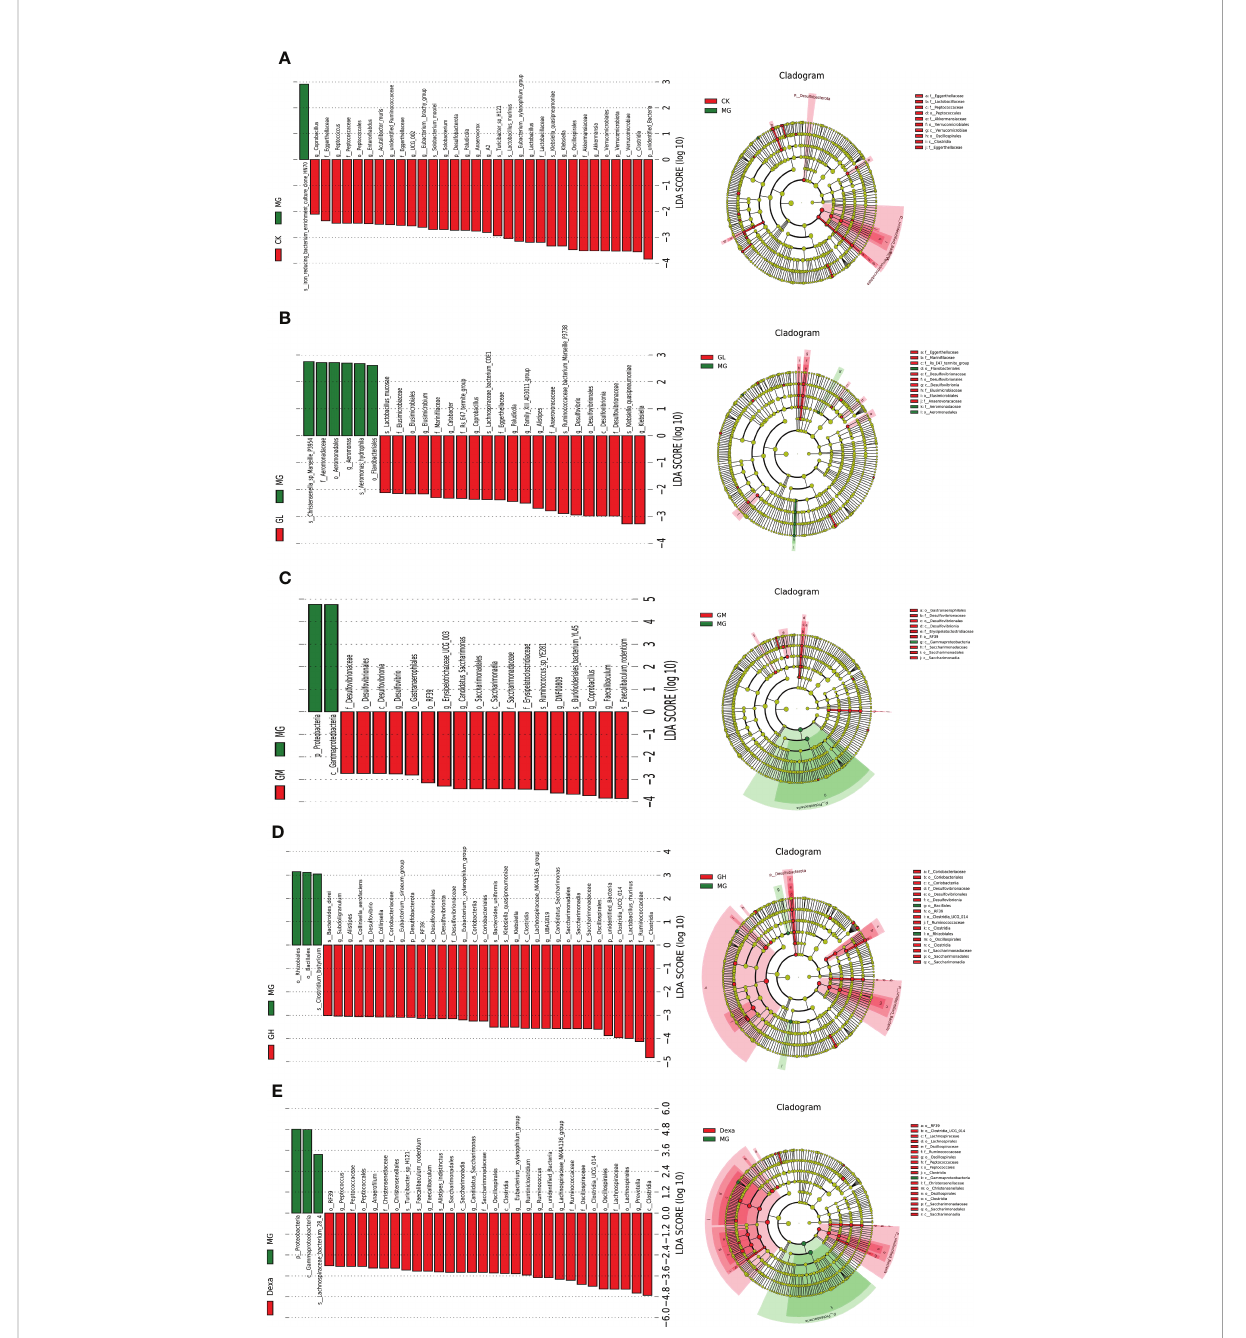
FIGURE 3 Left: histogram of linear discriminant analysis (LDA) value distribution (LDA>2); right: the evolutionary cladogram of LEfSe. Differential fl ora between two groups: CK and MG groups (A) , GL and MG groups (B) , GM and MG groups (C) , GH and MG groups (D) , Dexa and MG groups (E)